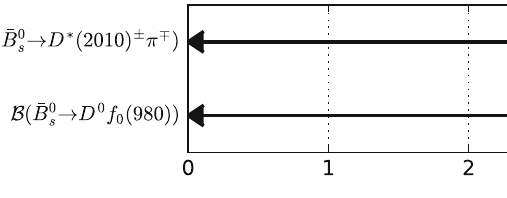
Fig. 155 Summary of the averages from Table 189